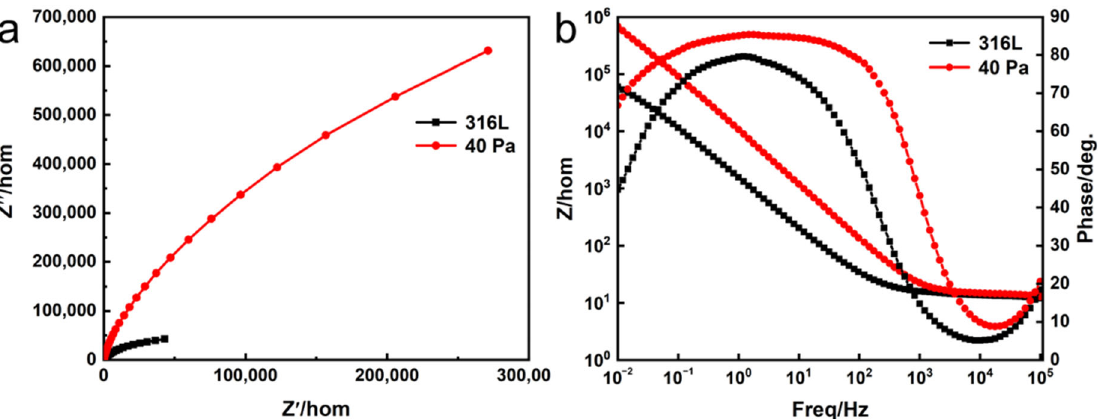
Figure 10. Electrochemical impedance spectra of Nb ‐ Zr alloying layers prepared at 40 Pa of pres ‐ sure: ( a ) Nyquist and ( b )